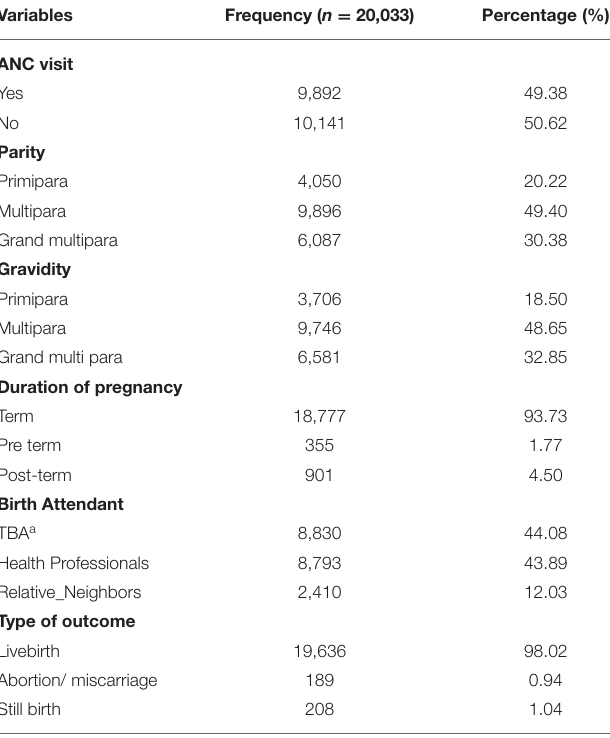
TABLE 2 | Pregnancy-related characteristics of the mothers in Kersa HDSS from 2015 to 2020. Variables